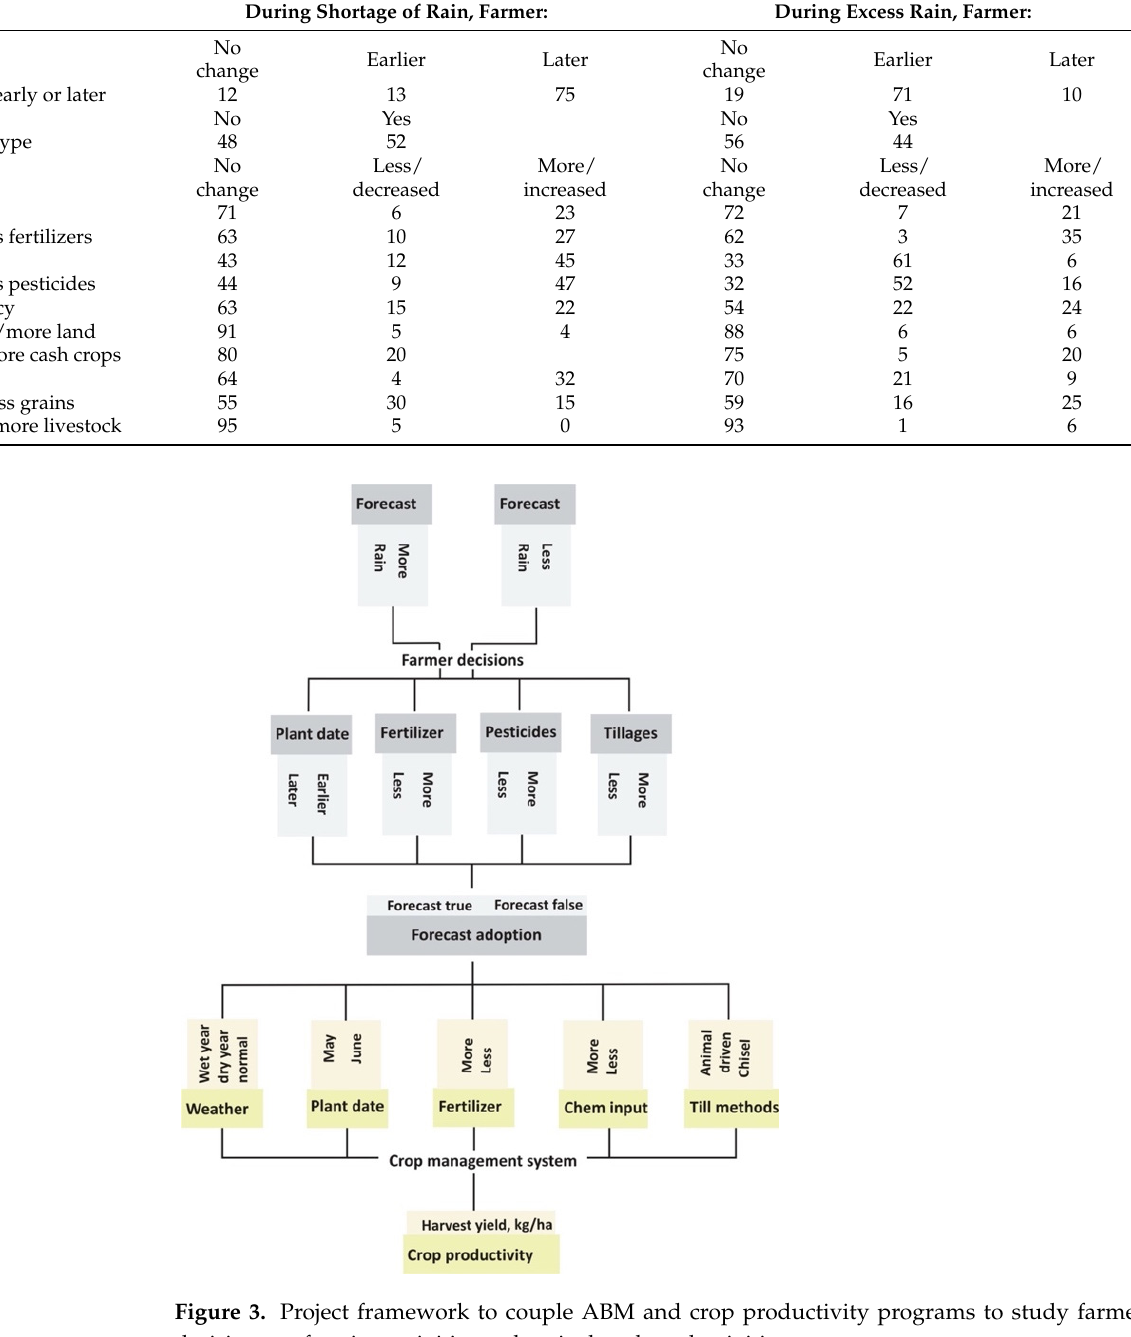
Table 1. Farmers’ activities under shortage and surplus of rainfall.